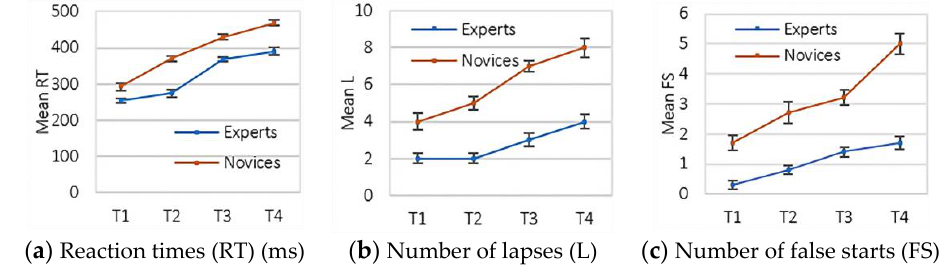
Figure 4. Means and standard errors of the PVT measures. Table 3. Results of the mixed model analysis of variance on PVT measures: Exp is expertise factor (experts vs. novices) related to the between-subjects design, and task is the task factor (tasks 1, 2, 3, and 4) related to the within-subjects